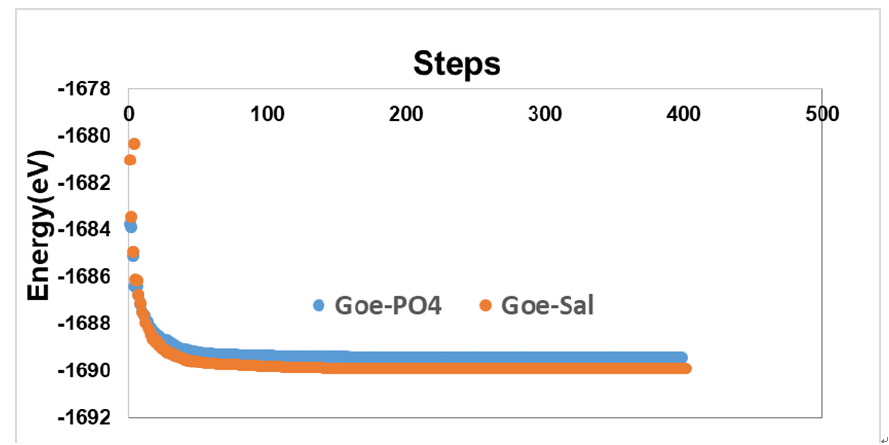
Figure 2. Models used to estimate Δ E ads for the exchange reaction of phosphate with salicylate on the goethite (210) ( a , b ) and (101) ( c , d ) surfaces.